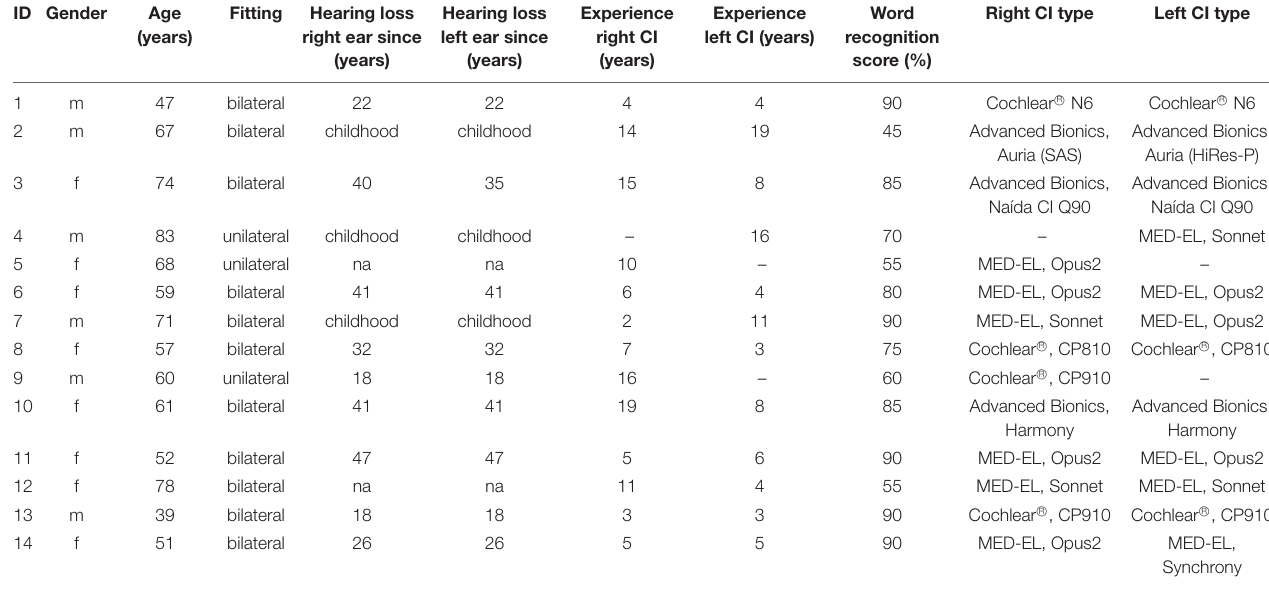
TABLE 1 | Characteristics of the cochlear implant